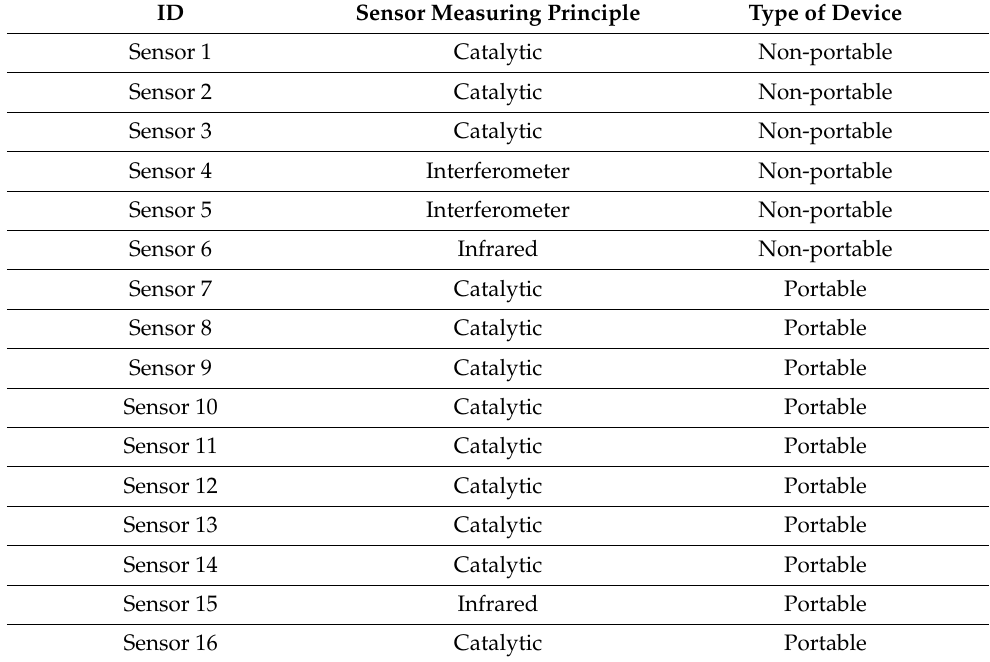
Table 1. Sensors